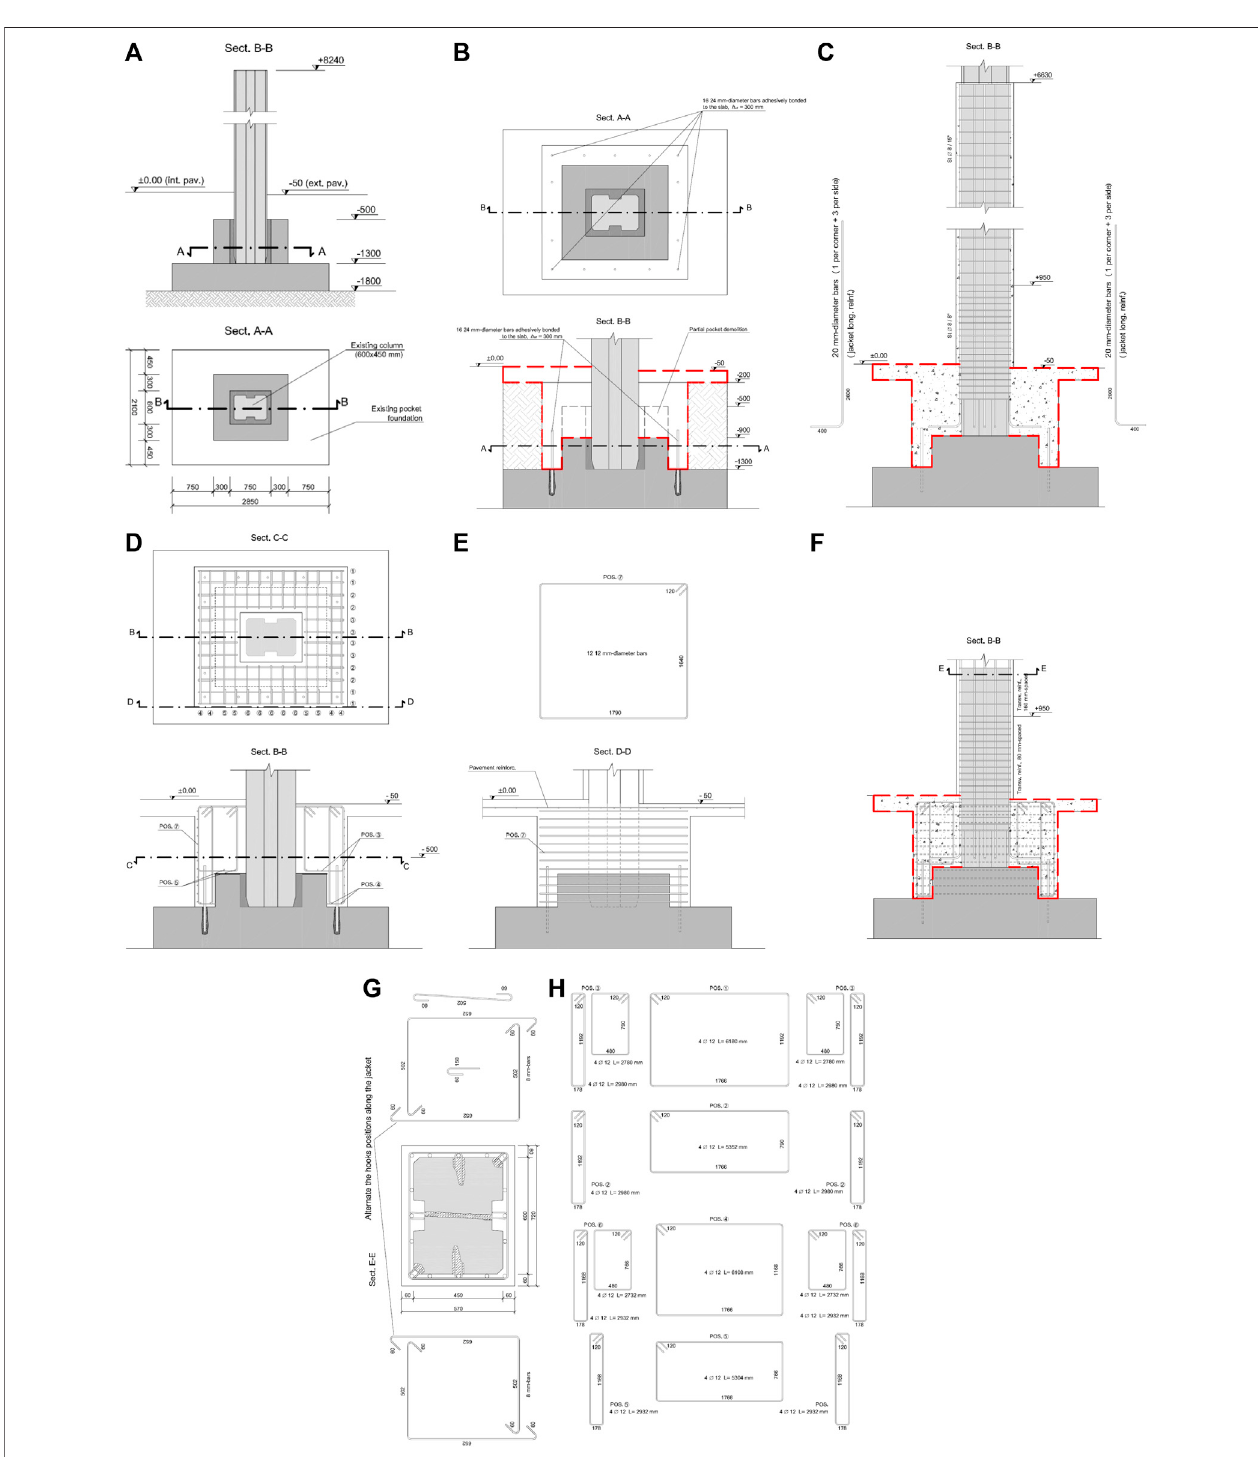
FIGURE 4 | (A) Precast RC column needing both fl exural strengthening and stiffening; RC jacketing for the column of (A) : (B) partial pocket demolition and installation of bonded anchors into the existing slab; (C) positioning of jacket reinforcement; positioning of (D) vertical and (E) horizontal reinforcement for foundation strengthening; details of (F) fi nal column-to-foundation connection, (G) jacketed column cross-section, and (H) foundation vertical reinforcement shown in (D) . Dimensions in mm.